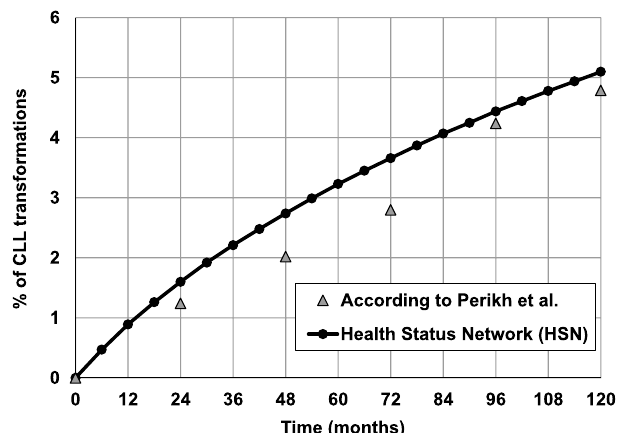
Figure 4. The probability of transformation of CLL into an aggressive form of leukemia within 10 years from the CLL diagnosis. Comparison of the probability predicted by the Health Status Network and reported by Perikh et al. 39 .